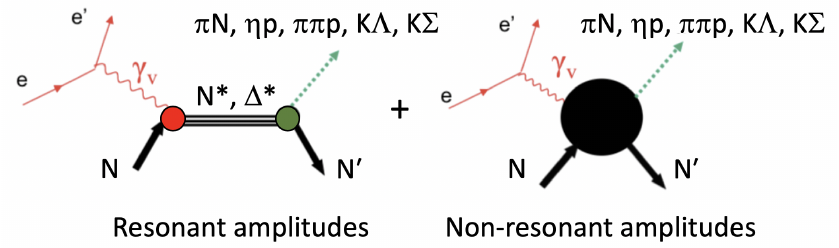
Figure 5. Resonant and non-resonant amplitudes contributing to exclusive meson electroproduction channels in the resonance